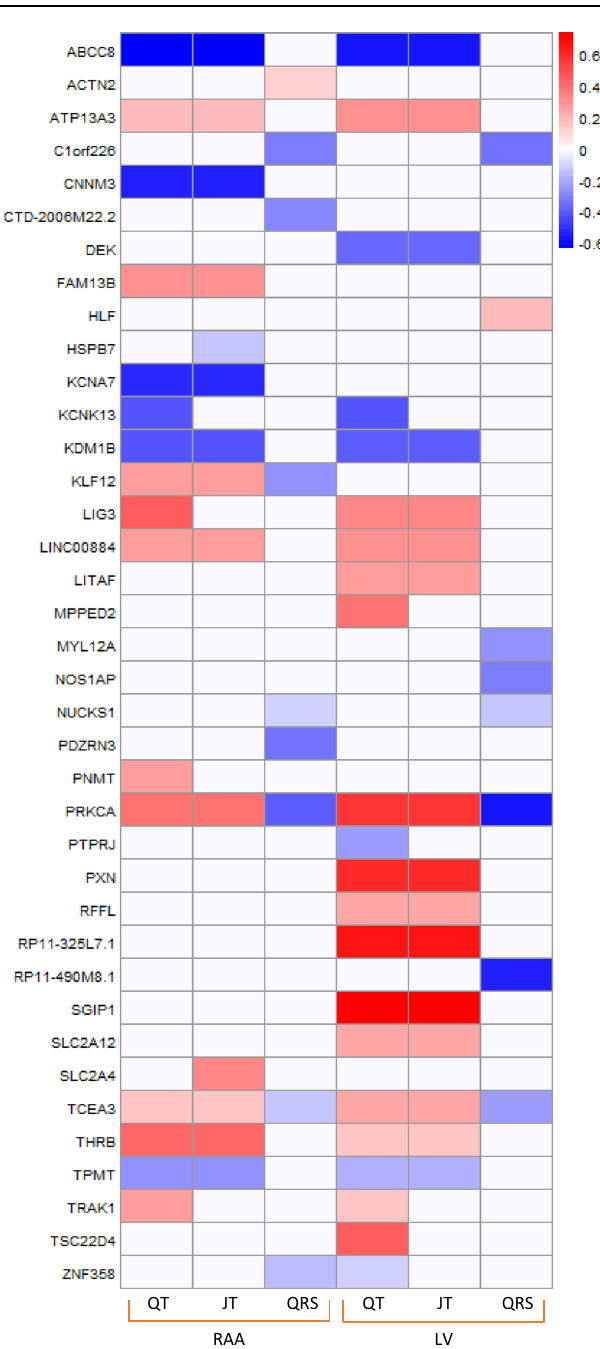
Fig. 4 | Comparison of co-localized eQTL signals for QT, JT, and QRS in right atrial appendage and left ventricle tissues. Colocalization analyses performed using data from GTEx (version 8), using the R package COLOC (methods). A pos- teriorprobabilityof>75%wasusedtodeclaresigni fi cance.Boxesarecolorcodedto show either increased (red) or decreased (blue) effect on tissue-speci fi c gene expression. The degree of shading re fl ects the normalized effect sizes (and there- fore no units) from the slope of the linear regression model for the effect allele relative to the non-effect allele (see methods for more information). The direction of effect has been aligned to the ECG trait prolonging allele. Y axis: Transcripts. RAA: Right atrial appendage, LV: Left